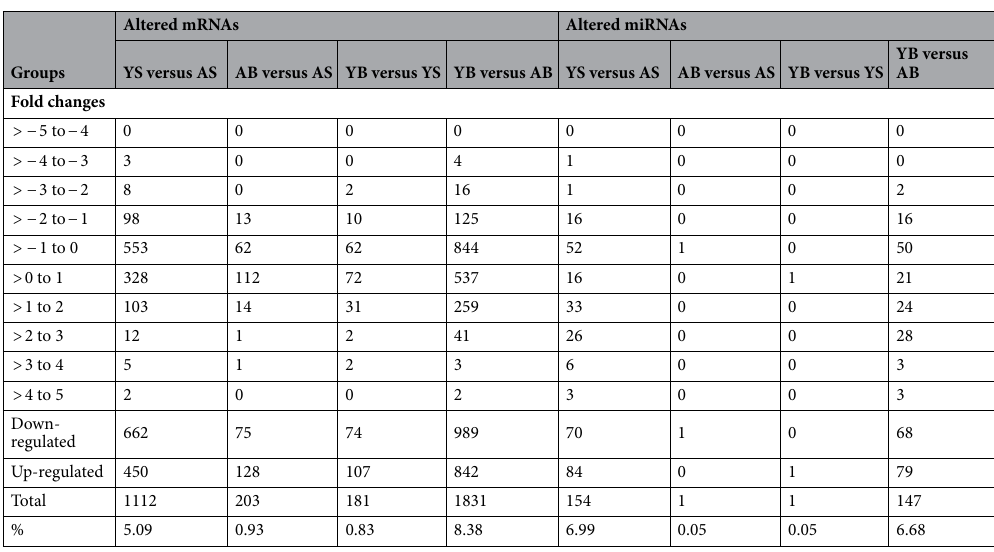
Table 1. The number of differently expressed mRNA and miRNAs in mouse gastrocnemius between young sham (YS), young burn (YB), adult sham (AS), and adult burn (AB) groups. 21,859 of protein-coding (39.45%) and 2202 miRNA counts (3.97%) were detected from a total of 55,401 grand